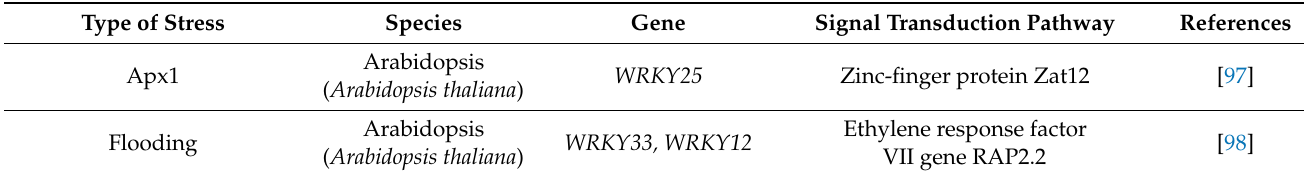
Table 3. WRKY transcription factors that induce oxidative stress responses during an exposure to other